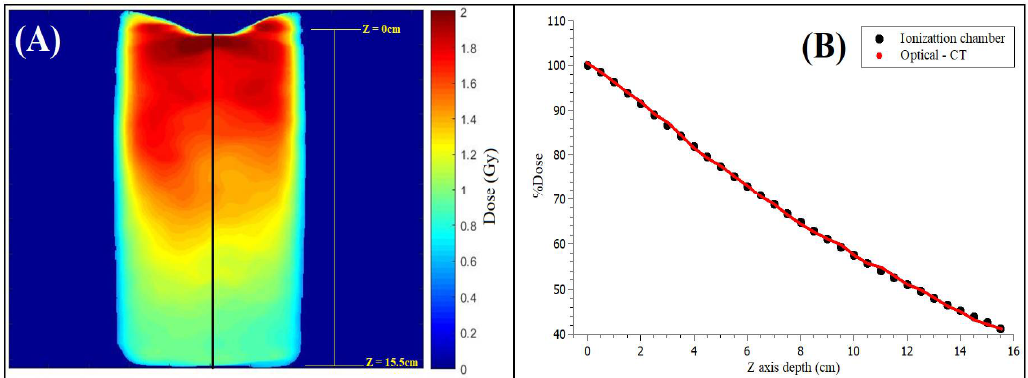
dose versus attenuation coefficient, starts at a dose of 0.8 Gy, corresponding to 40% of the total dose.